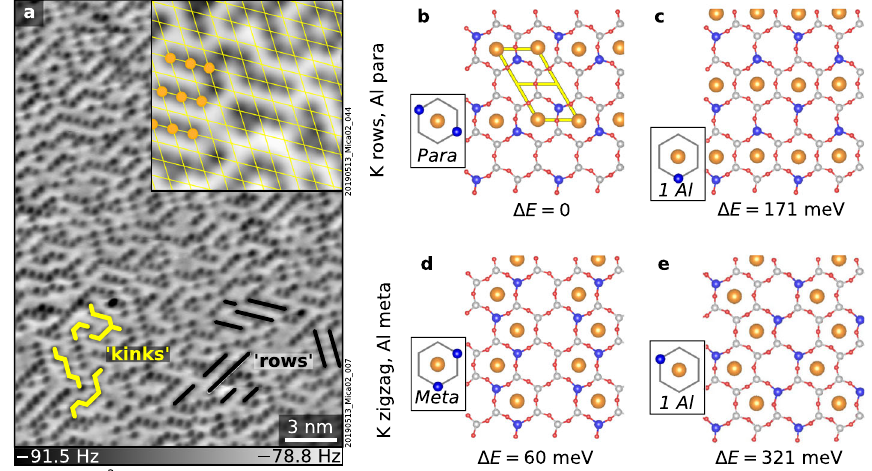
Fig.3|DistributionsofsurfaceK+andsubsurfaceAl3+ions.a nc-AFMimagesof a UHV-cleaved mica surface. Ions arranged in alternating rows and 120° kinks, the most common arrangements, are marked in black and yellow, respectively. The 5×5nm 2 inset highlights the hexagonal lattice of mica (yellow) and local K + order as alternating rows (orange). b – e DFT-calculated surface structures viewed from